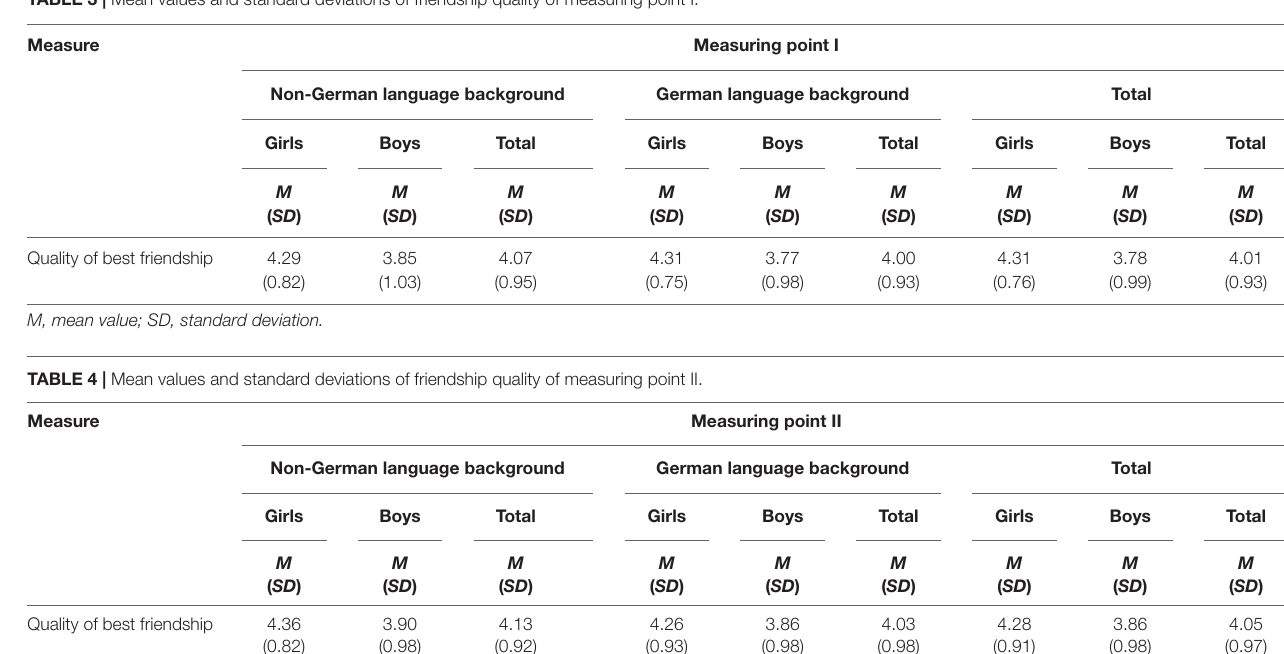
TABLE 3 | Mean values and standard deviations of friendship quality of measuring point I. Measure